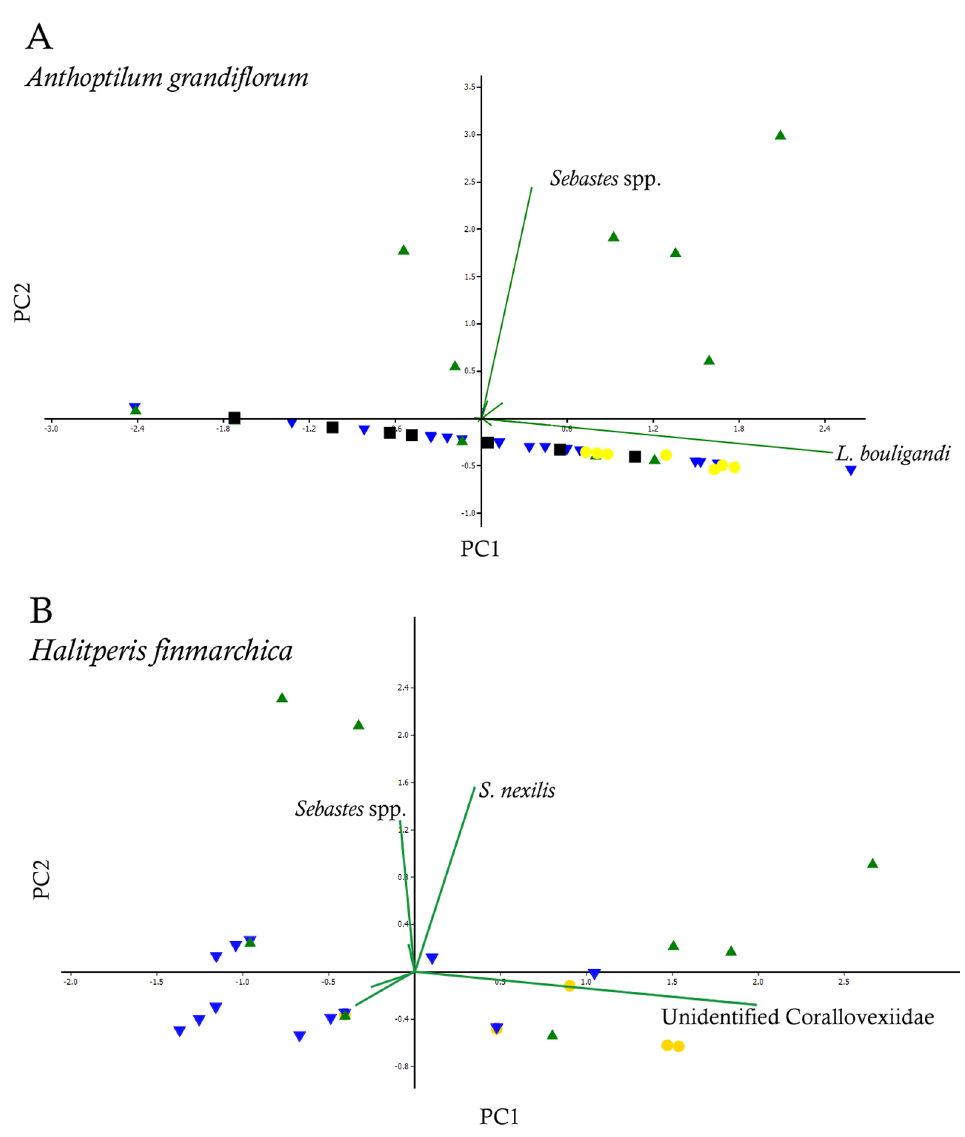
Figure 7. Principal component analyses and biplots based on the associated species of Anthoptilumgrandiflorum (A, B) and Halipteris finmarchica (C, D). Green up triangle: spring; yellow circle: summer; blue down triangle: fall; black square: winter.